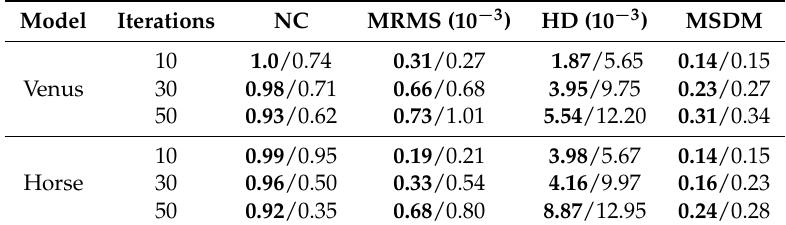
Table 20. Results of quality and robustness comparison with Wang et al.’s scheme [3] against Laplacian smoothing ( λ = 0.1) measured in terms of MRMS, HD, MSDM, and